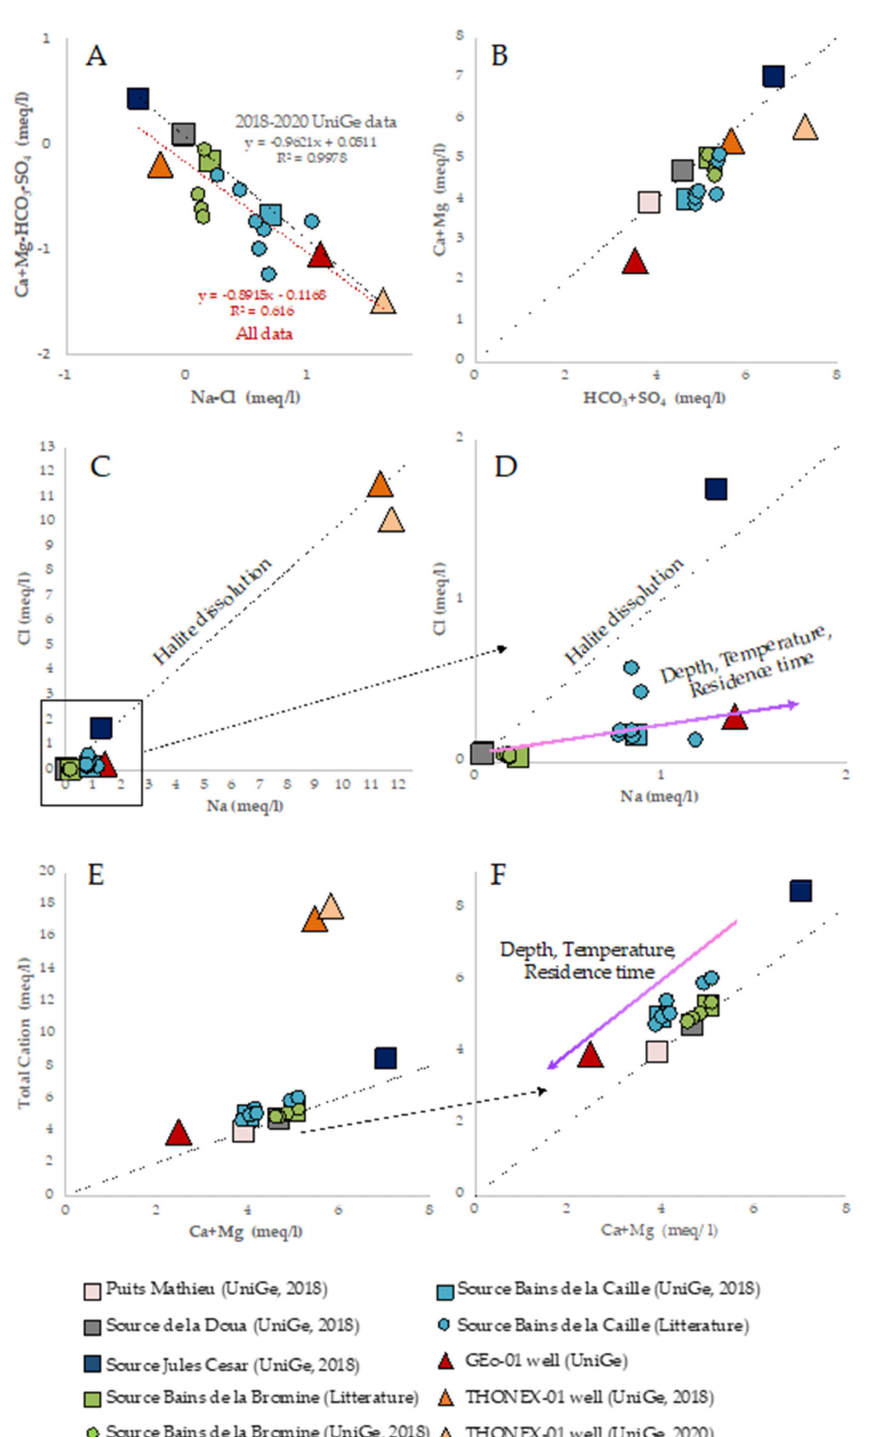
Figure 6. Correlations between major ions in the sampled waters. ( A ): Correlation between Na-Cl and Ca+Mg+HCO 3 +SO 4 concentration with indication of the trend resulting from all the data and the data collected by University of Geneva in 2018 and 2020 only. ( B ): binary plot of HCO 3 +SO 4 vs. Ca+Mg to identify correlation with evaporitic host rocks. ( C ): Na-Cl correlation to identify potential contribution from halite dissolution and ( D ): detail on the analyzed samples excluding Thonex-01 well. ( E ): Ca+Mg vs Total cation correlation to identify disequilibria within to major cations and ( F ): detail on the analyzed samples excluding Thonex-01